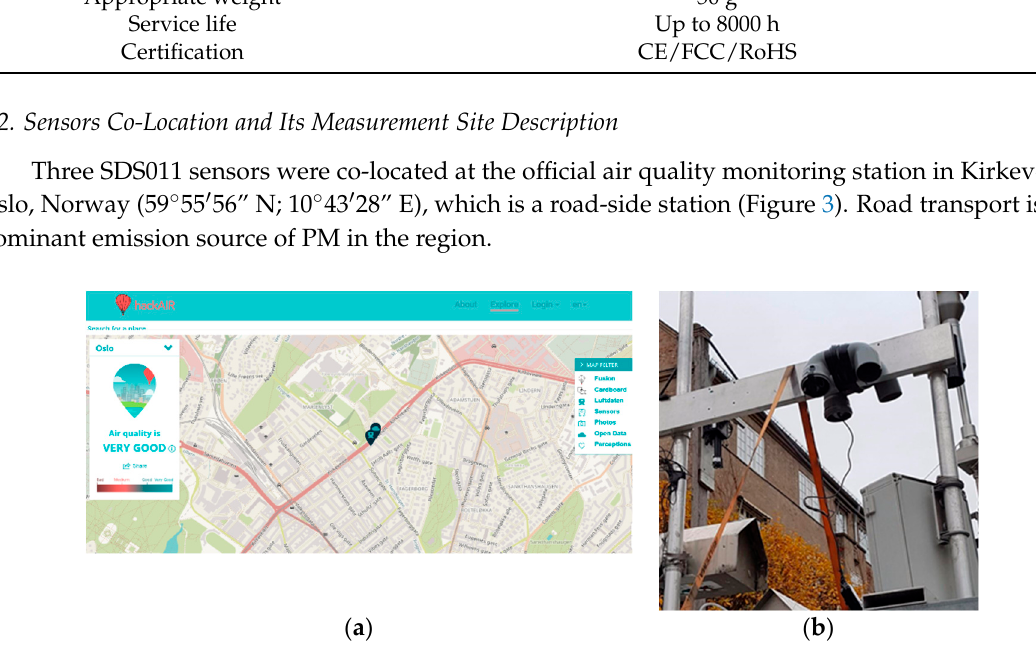
Figure 3. Sensors measurement sites and co-location: ( a ) sensors measurement site; ( b ) sensors co- location).